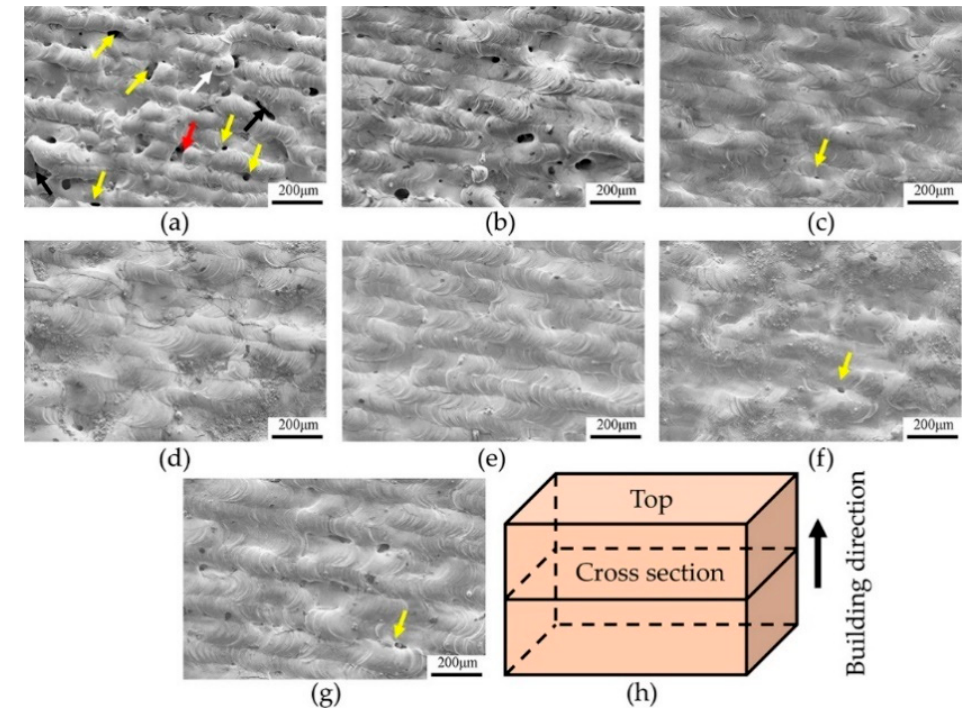
Figure 4. The top surface morphology of tungsten samples under different process parameters. ( a ) T5, ( b )T14, ( c )T23, ( d )T20, ( e )T26, ( f )T22, ( g )T24, and ( h ) illustration of sample orientation.